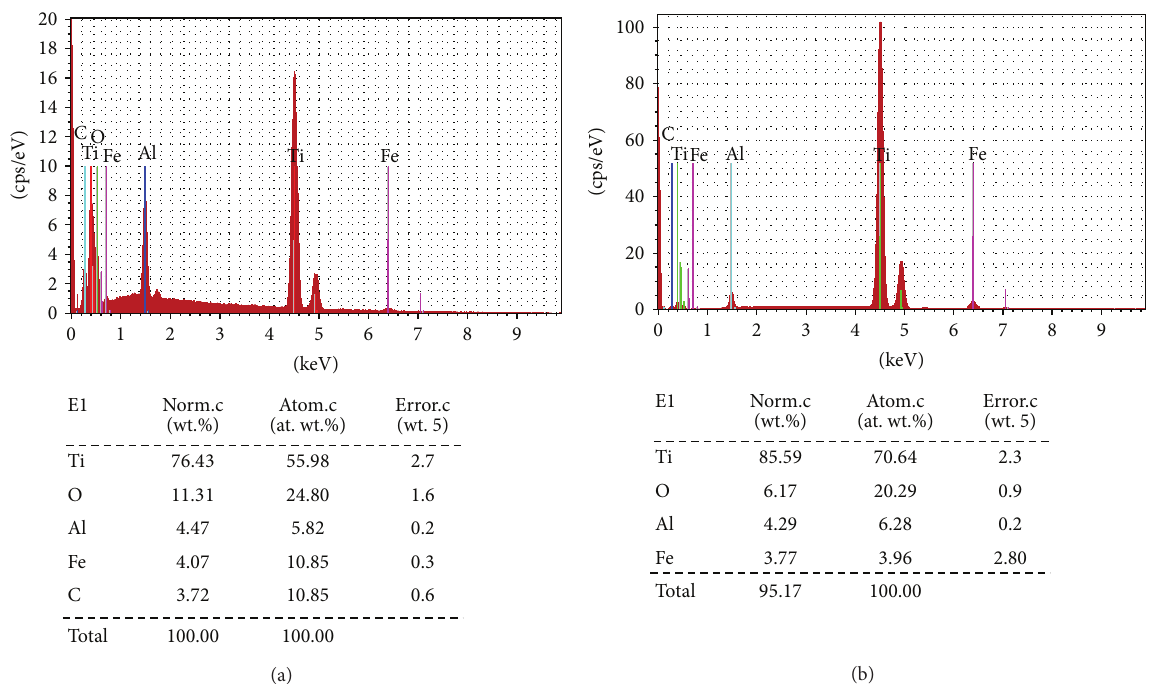
Figure 8: EDS spectrum of titanium (Grade 5) alloy under dry sliding conditions at sliding speed of 600 rpm and applied normal load of (a) 50 N and (b) 90N, respectively.